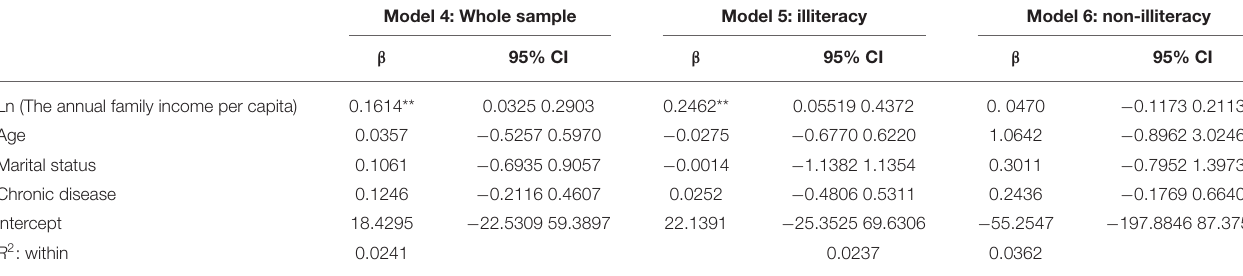
TABLE 3 | Fixed effect modeling of changes in BMI and the annual family income per capita between 2010, 2014, and 2018. Model 4: Whole